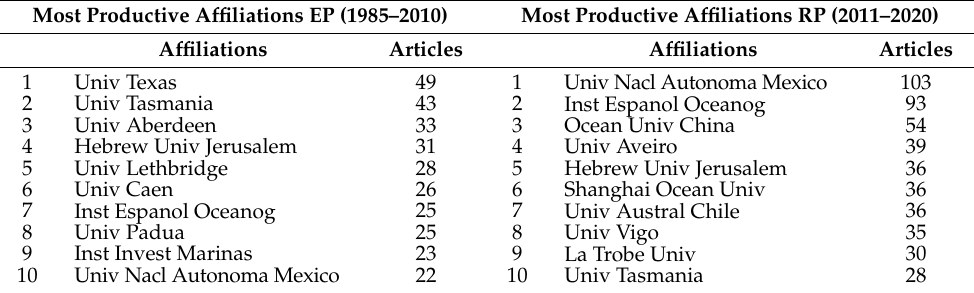
Table 5. The first ten most productive affiliations from 1985 to 2010 (“earlier period”: EP) and from 2011 to 2020 (“recent period”: RP). The first three items are in bold.